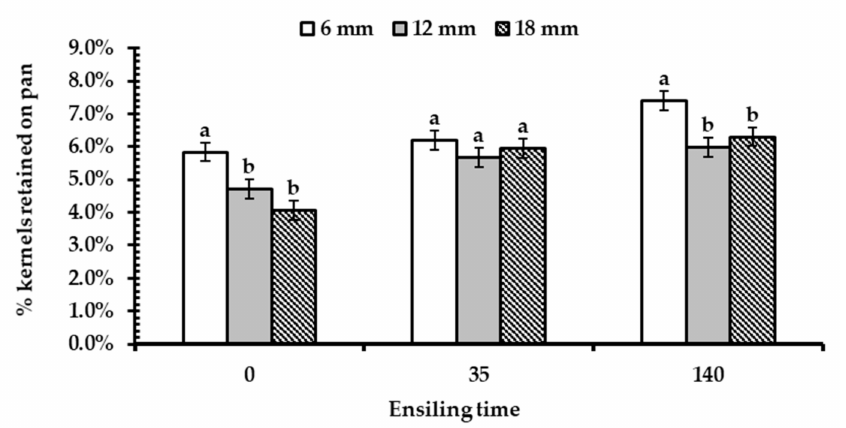
Figure 2. Interaction between theoretical length of cut and ensiling time (day) for kernels retained in the pan ( p = 0.10; SEM = 0.21) in whole-plant corn silage harvested with a self-propelled forage harvester. SEM: standard error of mean. a,b Means in the same ensiling time with different superscript letters differ by Tukey test ( p ≤